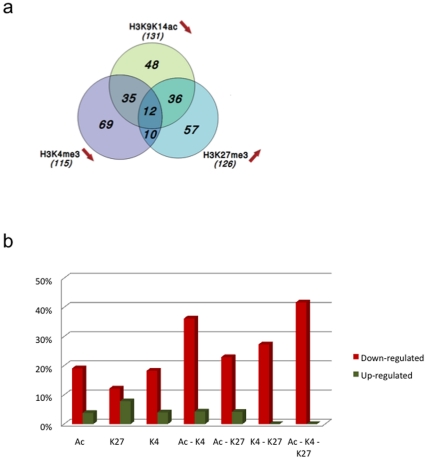
Chromatin modifications at PLZF/RARA target genes.(a) Venn diagram representing the combinatorial changes of histone modifications at PLZF/RARA target genes. The total number of PLZF/RARA target gene promoters displaying decreased levels of H3K14ac or H3K4me3, or increased levels of H3K27me3 is also indicated. (b) The bar plot indicates the percentages of either repressed or induced genes, accordingly to the combinatorial changes of histone modifications. The percentages are relative to gene numbers indicated in Figure 3a.